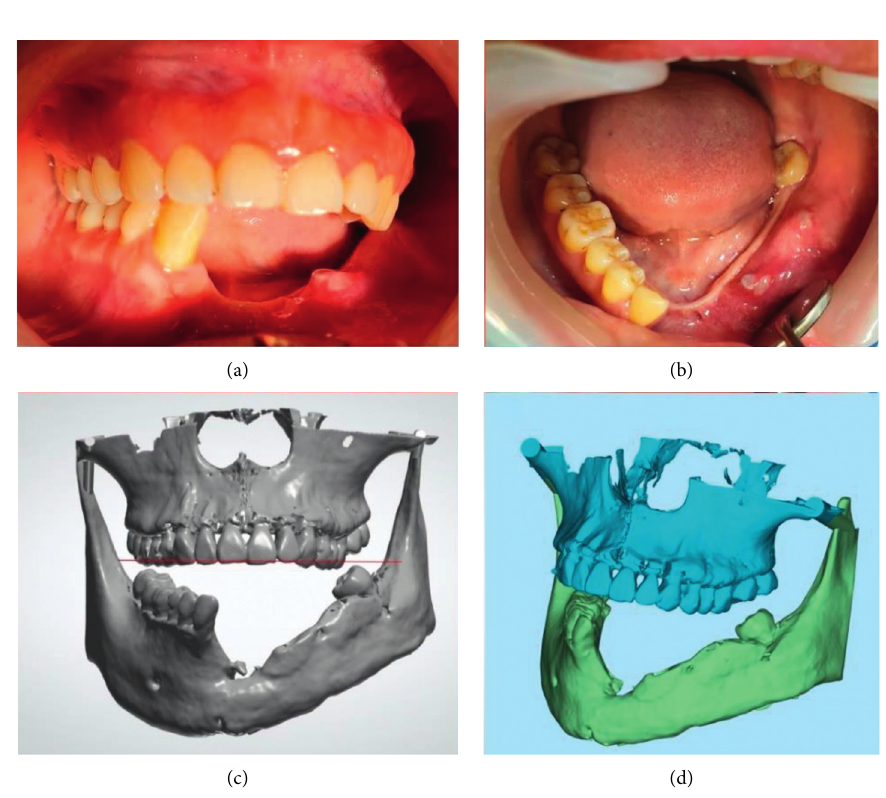
Figure 2: Fibula free flap in the mandibular arch: clinical pictures (a, b) and 3D views (c, d).